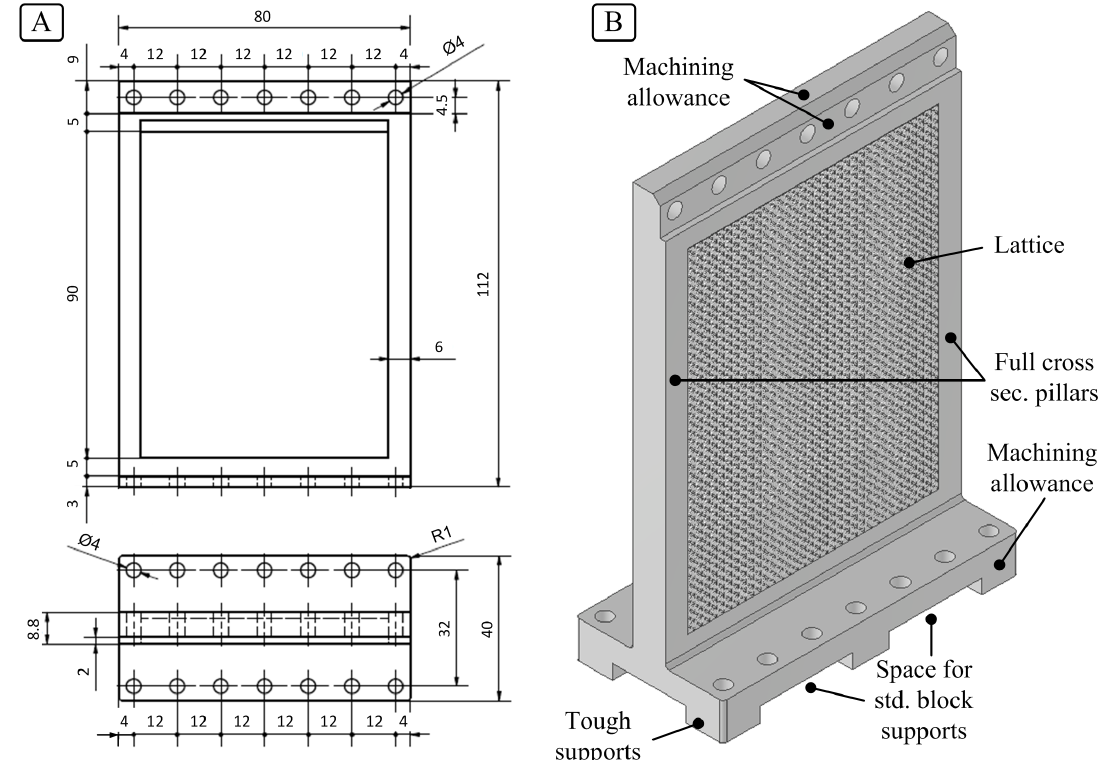
Figure 6. Blade-like benchmark geometry: dimensioned orthogonal view ( A ) and isometric view of the raw part after 3D printing ( B